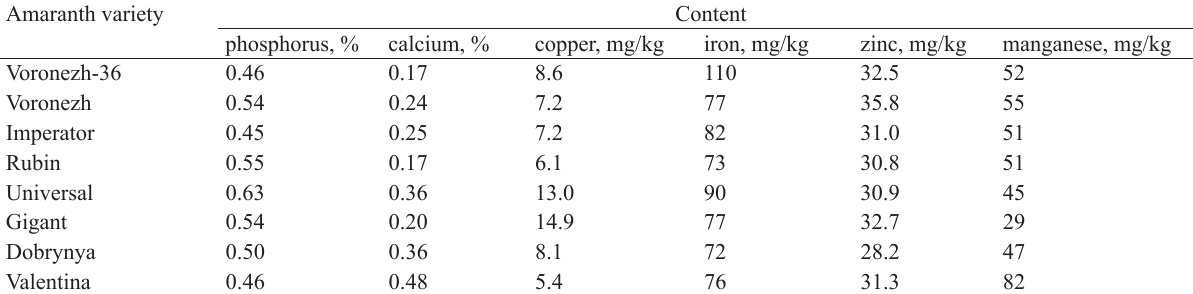
Table 2 Mineral substances in amaranth grain Amaranth variety Content